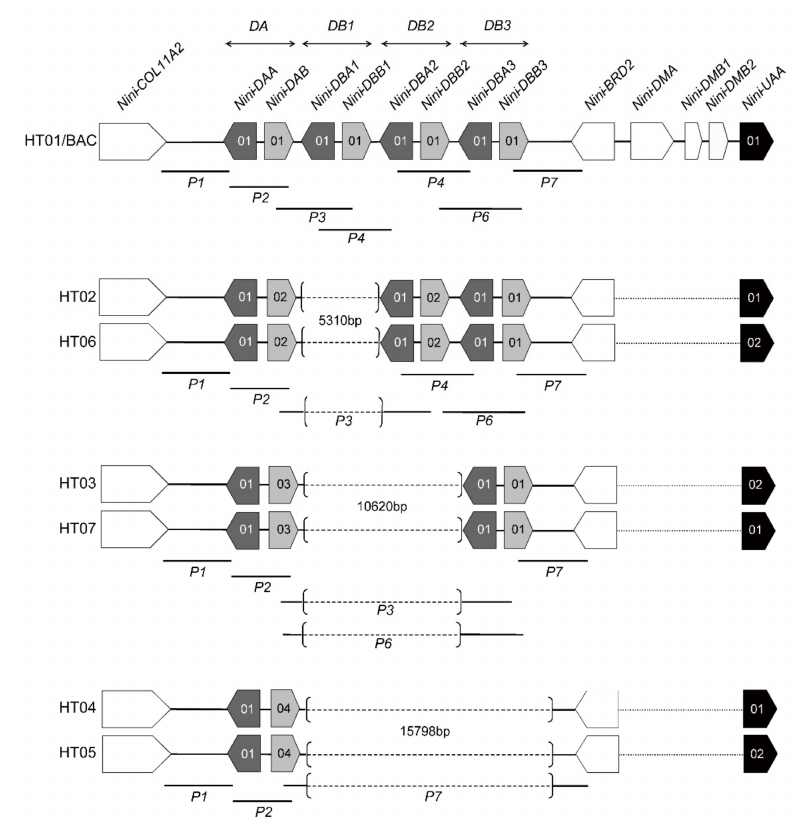
Figure 2. Genomic structures of seven crested ibis MHC haplotypes. A total of seven haplotypes were inferred from genotype data, and their genomic structures of class II region were further determined by La-PCR using representative homozygotes. Dark and light grey boxes indicate the II α and II β genes, respectively, with numbers indicating di ff erent alleles on the full-length level. Black boxes indicate the major class I gene ( UAA ) and white boxes indicate other functional genes [20]. Haplotypes are aligned, with bracketed dash lines representing deleted regions (the lengths were denoted aside) in relative haplotypes. Dotted lines between BRD2 and UAA represent the unsequenced region. Locations of the La-PCR fragments amplified by the six reported sets of primers (P1–P4, P6, and P7) [20] are marked below the